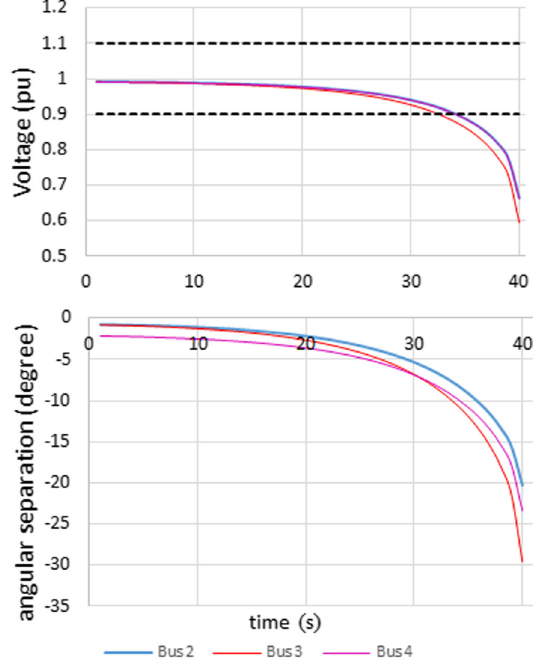
Fig. 10 Bus voltage and angular separation on MC load rise